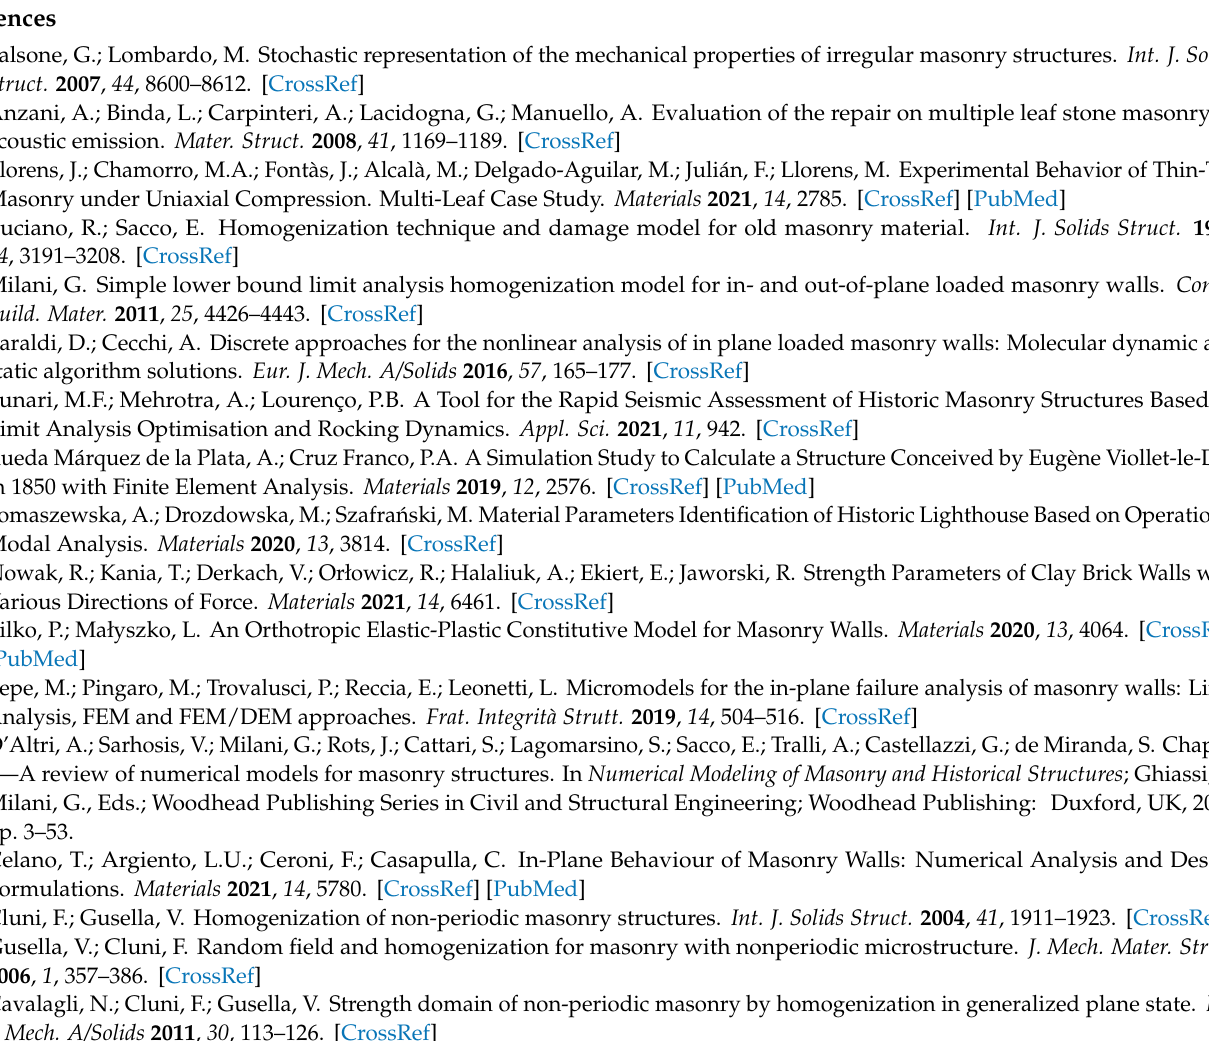
Figure A2. Values of λ r and λ t for various values of H / W and two different values of q